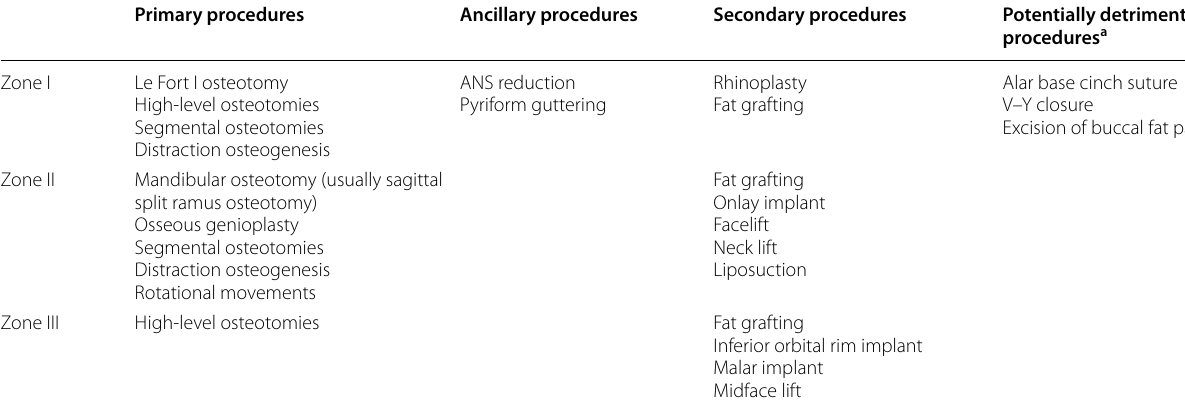
ANS Anterior nasal spine a This is based on clinical experience and views about the potential detrimental nature of such procedures may vary (see text for further